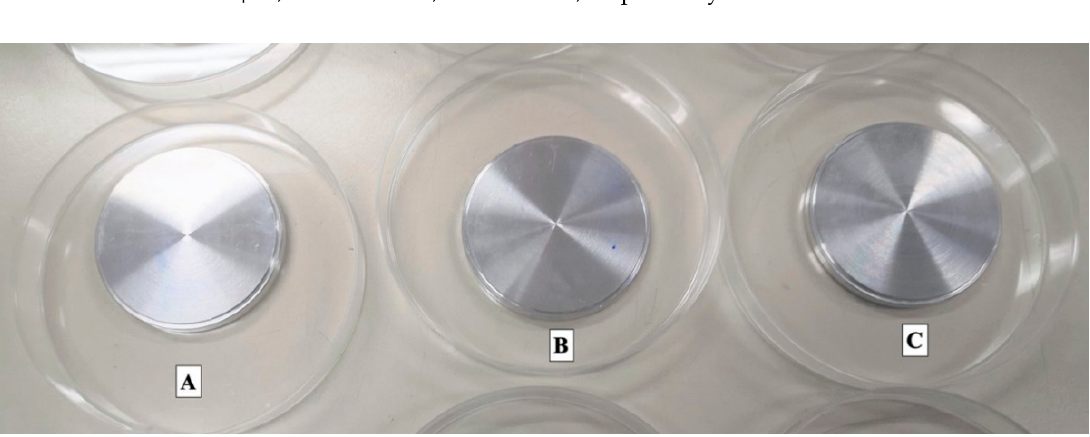
Figure 1. Representative image of aluminum disks with different roughness, ( A ) R0.25 μ m, ( B ) R0.5 μ m and ( C ) R1 μ m.